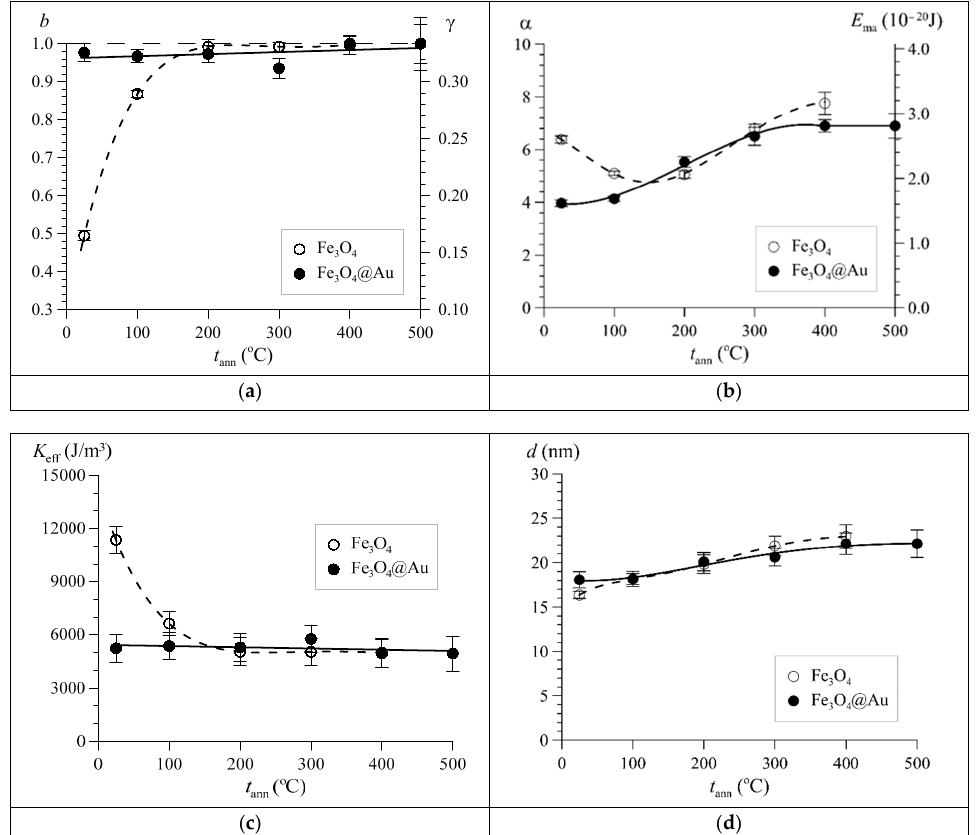
Figure 13. Dependences on the annealing temperature t ann of the molar concentration of maghemite b and the nonstoichiometry degree γ ( a ), the parameter of the multilevel superparamagnetic relax- ation model α and the magnetic anisotropy energy E ma ( b ), the magnetic anisotropy coefficient K eff ( c ), and the average size of the magnetic ordering region d ( d ) for nonstoichiometric magnetite in Fe 3 O 4 and Fe 3 O 4 @Au nanoparticles. The parameter of the multilevel superparamagnetic relaxation model α , equal to the ratio of the magnetic anisotropy energy to the thermal energy (4), and the magnetic ani- sotropy energy E ma as a function of the annealing temperature are shown in Figure 13b. It can be seen that for Fe 3 O 4 @Au nanoparticles, the energy E ma increases monotonically, while for Fe 3 O 4 nanoparticles, a rather “convoluted” dependence is observed at low an- nealing temperatures. This behavior of the dependence E ma ( t ann ) can be explained if we take into account the oxidation of nanoparticles not coated with gold. In accordance with the data on the molar concentration of maghemite b , the effective coefficients of magnetic anisotropy of nanoparticles K eff were determined, the results of which are shown in Figure 13c. As can be seen, for Fe 3 O 4 @Au nanoparticles, the K eff coefficient practically remains unchanged, while for Fe 3 O 4 nanoparticles it sharply decreases with temperature in accord- ance with the oxidation of nonstoichiometric magnetite to maghemite (Figure 13a). If this value differs for magnetic nanoparticles from the bulk samples of magnetite presented in [43–45], this may be due to size factors, as well as structural disordering of the initial mag- netite nanoparticles, which also leads to a change in the magnetic parameters. Using the results of estimates of the effective coefficient of magnetic anisotropy, in accordance with (4), the average sizes of the magnetic ordering regions of Fe atoms in nonstoichiometric magnetite for Fe 3 O 4 and Fe 3 O 4 @Au nanoparticles were calculated; they are presented in Figure 13d. The assessment of the “magnetic ordering region” for un- coated Fe 3 O 4 samples annealed at 500–800 °C and for coated Fe 3 O 4 @Au samples at 600– 800 °C was not carried out due to the small contribution of Fe 3- γ O 4 to the experimental spectrum (see Figure 9e,f), making it impossible to reliably find the values of the relaxa- tion model parameter α (see Formula (4) and Figure 9e,f). It is evident that with an increase in the annealing temperature, the average sizes of these regions gradually increase both due to the oxidation of nanoparticles and due to their structural and magnetic ordering. Note that the average size of the magnetic ordering region increases from 16.4 ± 0.4 to 18.1 ± 0.9 nm as a result of gold coating of the initial nanoparticles, which is associated with oxidation during gold coating. At the same time, the obtained values of the average size of the magnetic ordering region are in good agreement with the data of scanning electron microscopy (Figure 2a). As a result of model fitting of the Mössbauer spectra of Fe 3 O 4 and Fe 3 O 4 @Au nano- particles subjected to thermal annealing, the values of hyperfine parameters of subspectra